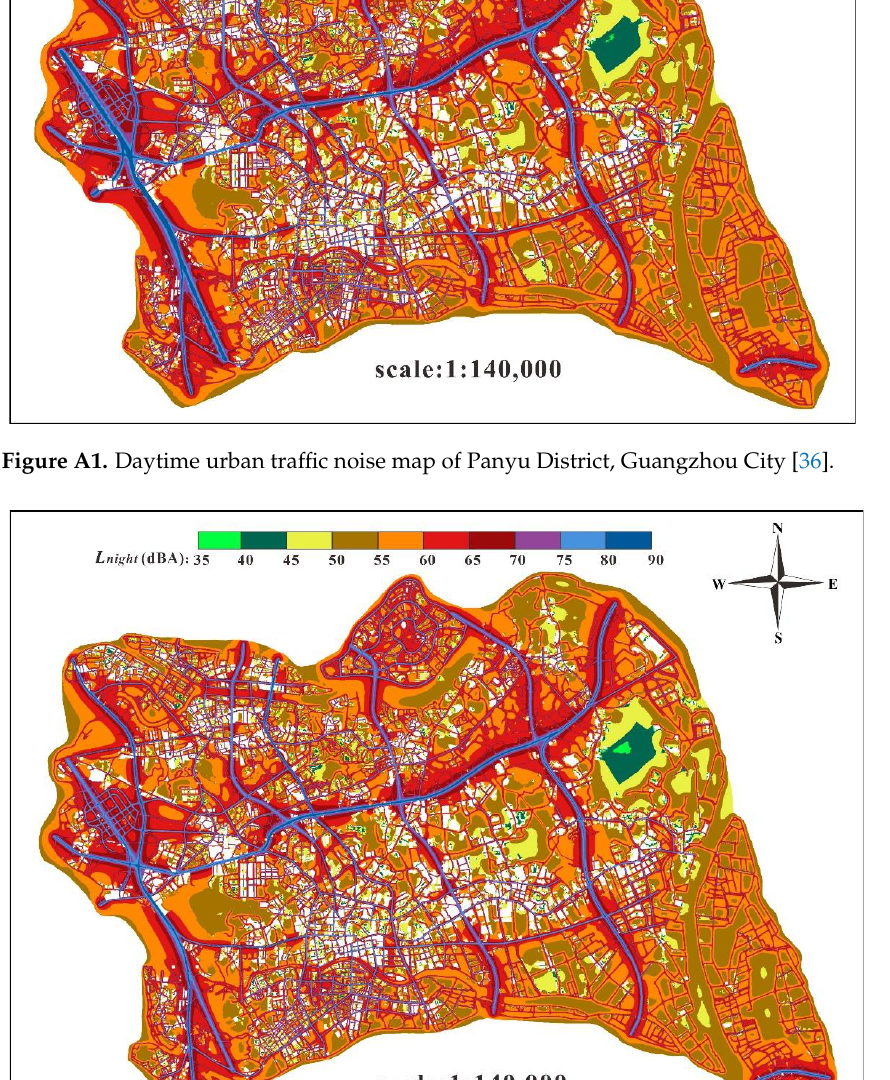
Figure A3. Day – night urban traffic noise map of Panyu District, Guangzhou City [36].